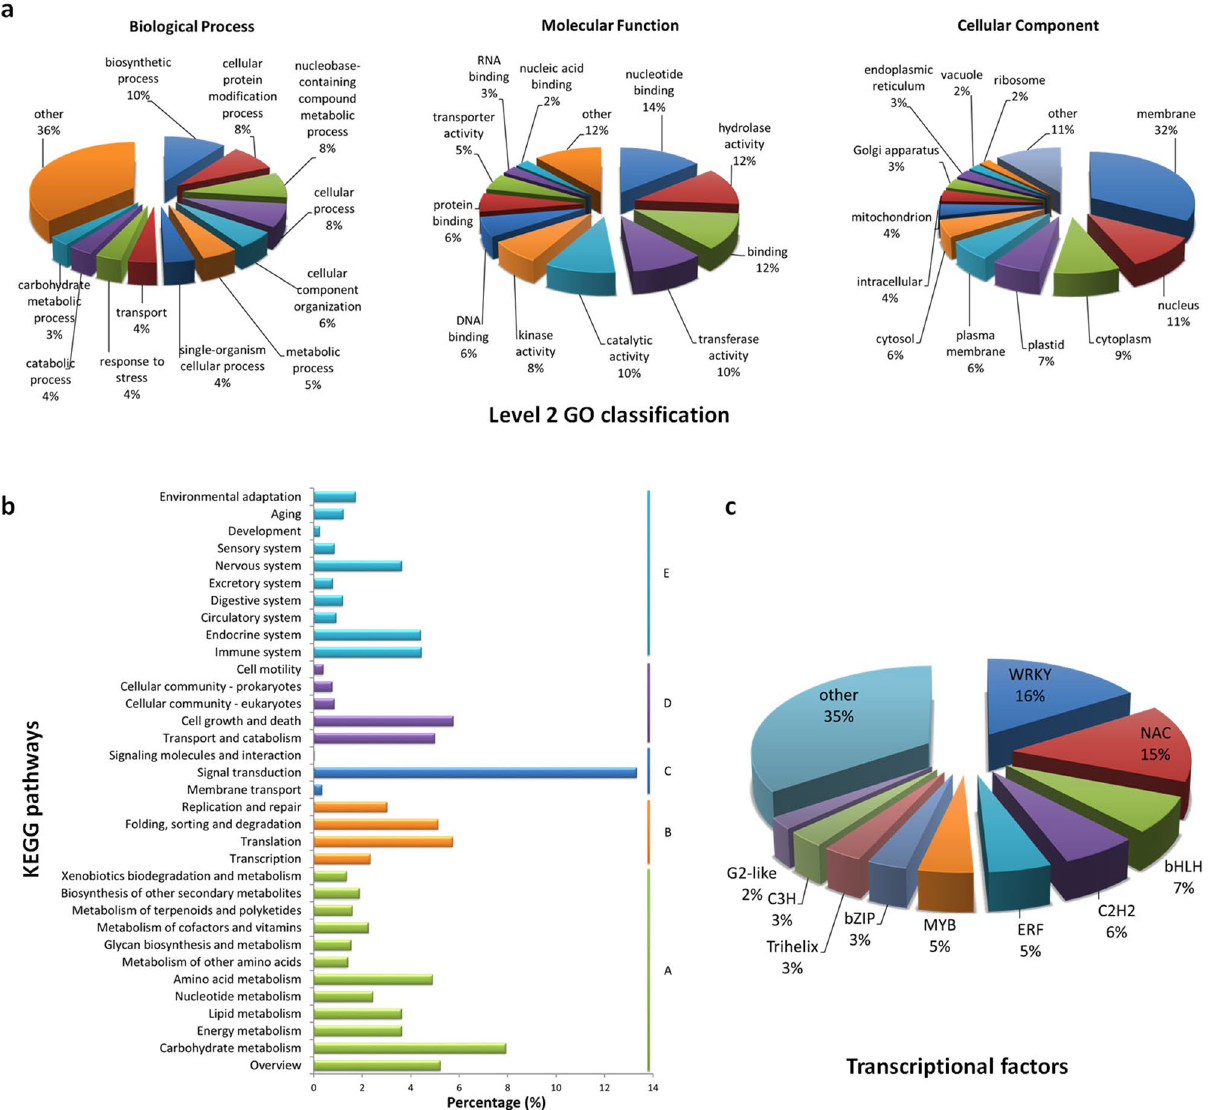
Figure 1. Functional annotation of SSR-containing unigenes in C. japonica . ( a ) Level 2 GO classification of the annotated SSR-containing unigenes. ( b )KEGG classification of the annotated unigenes. ( c ) Putative TF gene families among the annotated SSR-containing